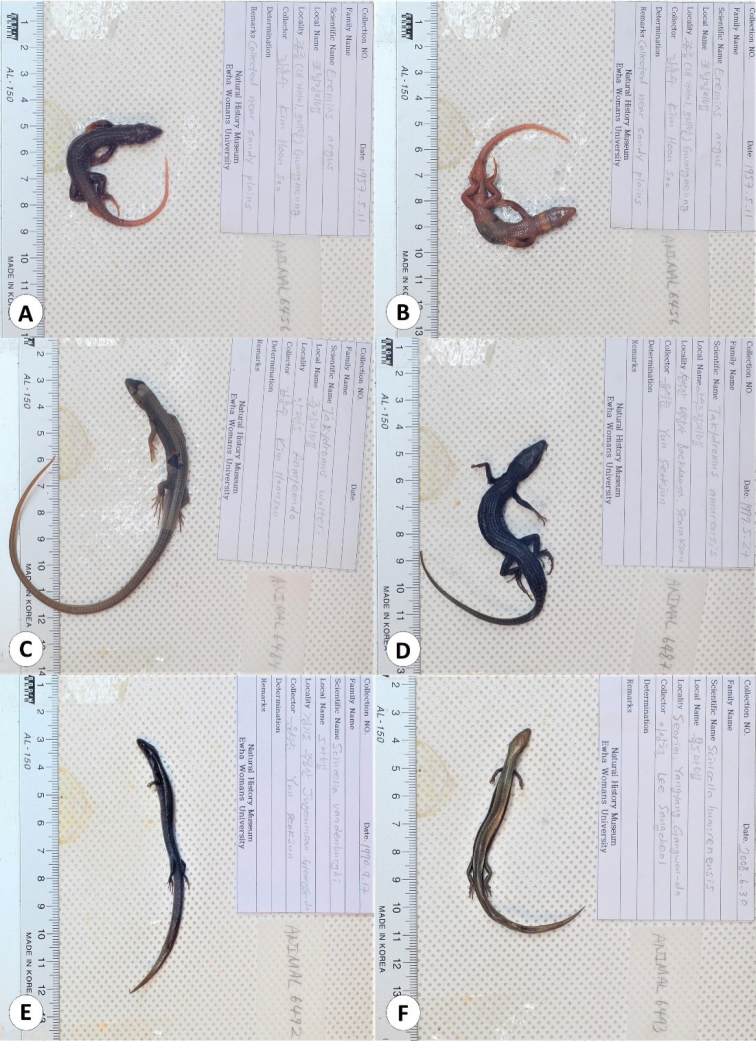
Lizard species of the Republic of Korea represented in the collection of the EWNHMAEremias
argus (EWNHM-ANIMAL 6456; dorsal view) BE.
argus (EWNHM-ANIMAL 6456; ventral view) CTakydromus
wolteri (EWNHM-ANIMAL 6484) DTakydromus
amurensis (EWNHM-ANIMAL 6487) EScincella
vandenburghi (EWNHM-ANIMAL 6492) FScincella
huanrenensis (EWNHM-ANIMAL 6493).